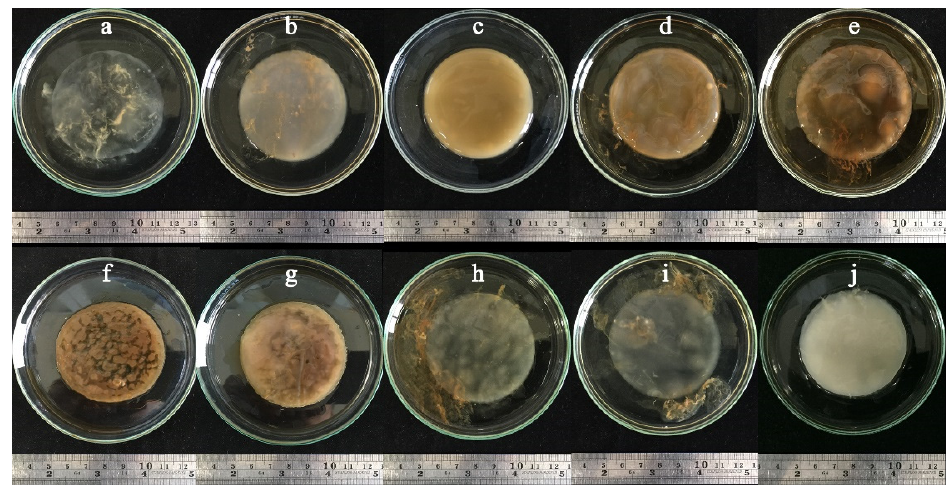
Figure 5. The bacterial cellulose pellicles produced by Komagataeibacter maltaceti P285 cultured sugarcane at the concentration of 2 ( a ); 4 ( b ); 8 ( c ); 16 ( d ); and 32 ( e ) % ( w/v ), honey solution at the ration of honey to water as 1:2 ( f ); 1:4 ( g ); 1:8 ( h ); and 1:16 ( i ); and HS medium ( j ). All cultures were incubated at 30 ◦ C for 7 days.